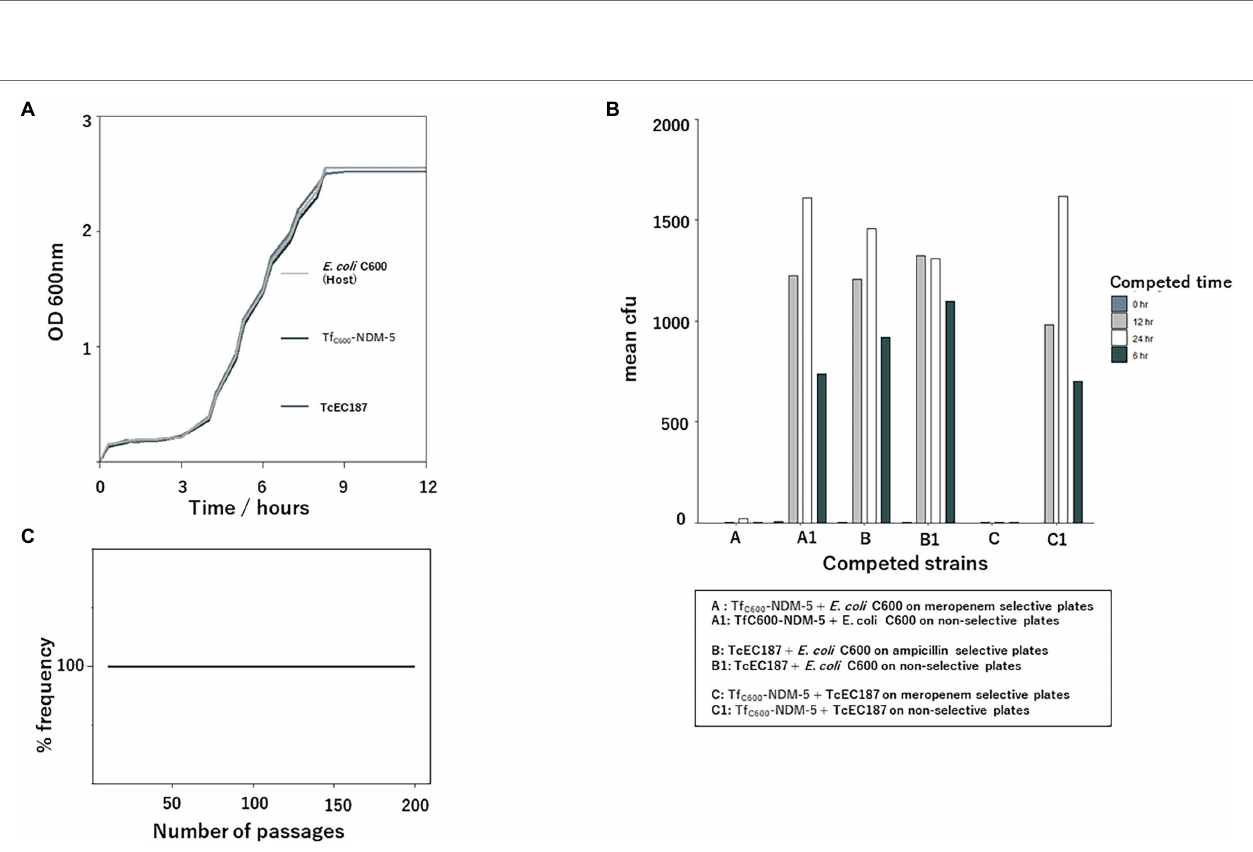
FIGURE 4 | Linearized comparison of bla NDM-5 genetic environment of pKO_4-NDM-5, MH781720, and LC000627. Similar features are represented by the same color. The bla NDM-5 gene, mobile genetic elements, and other immediate CDSs are represented by red, yellow, and purple colors, respectively.